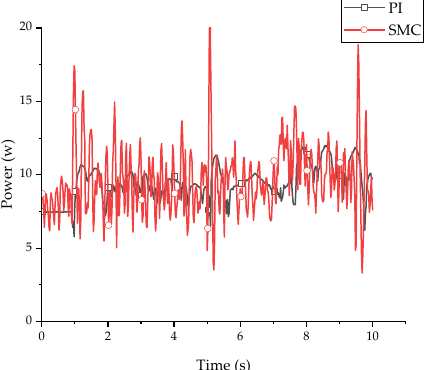
Figure 10. Power consumption comparison between the two control schemes graph.